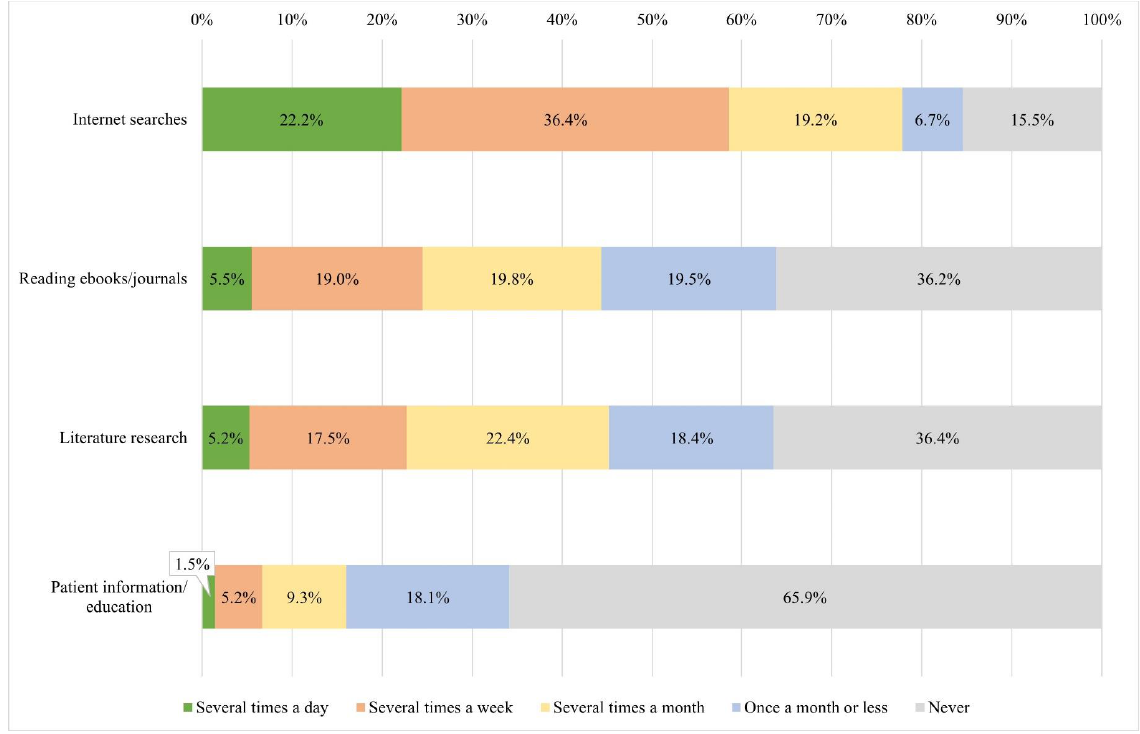
Figure A6. Knowledge Acquisition and Training.